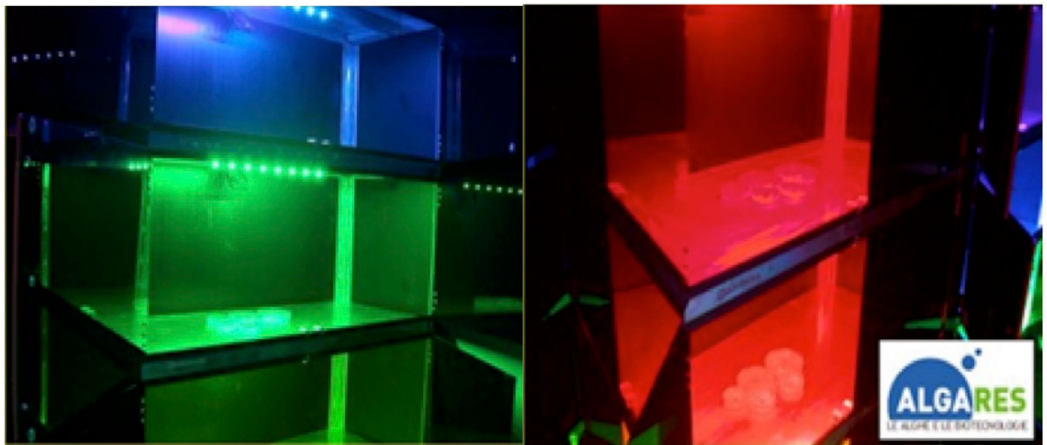
Figure 4. Experimental chamber used to assess the effectiveness of monochromatic wavelength against photosynthetic biodeteriogens (photo, L.Bruno, University Tor Vergata, Rome, Italy).